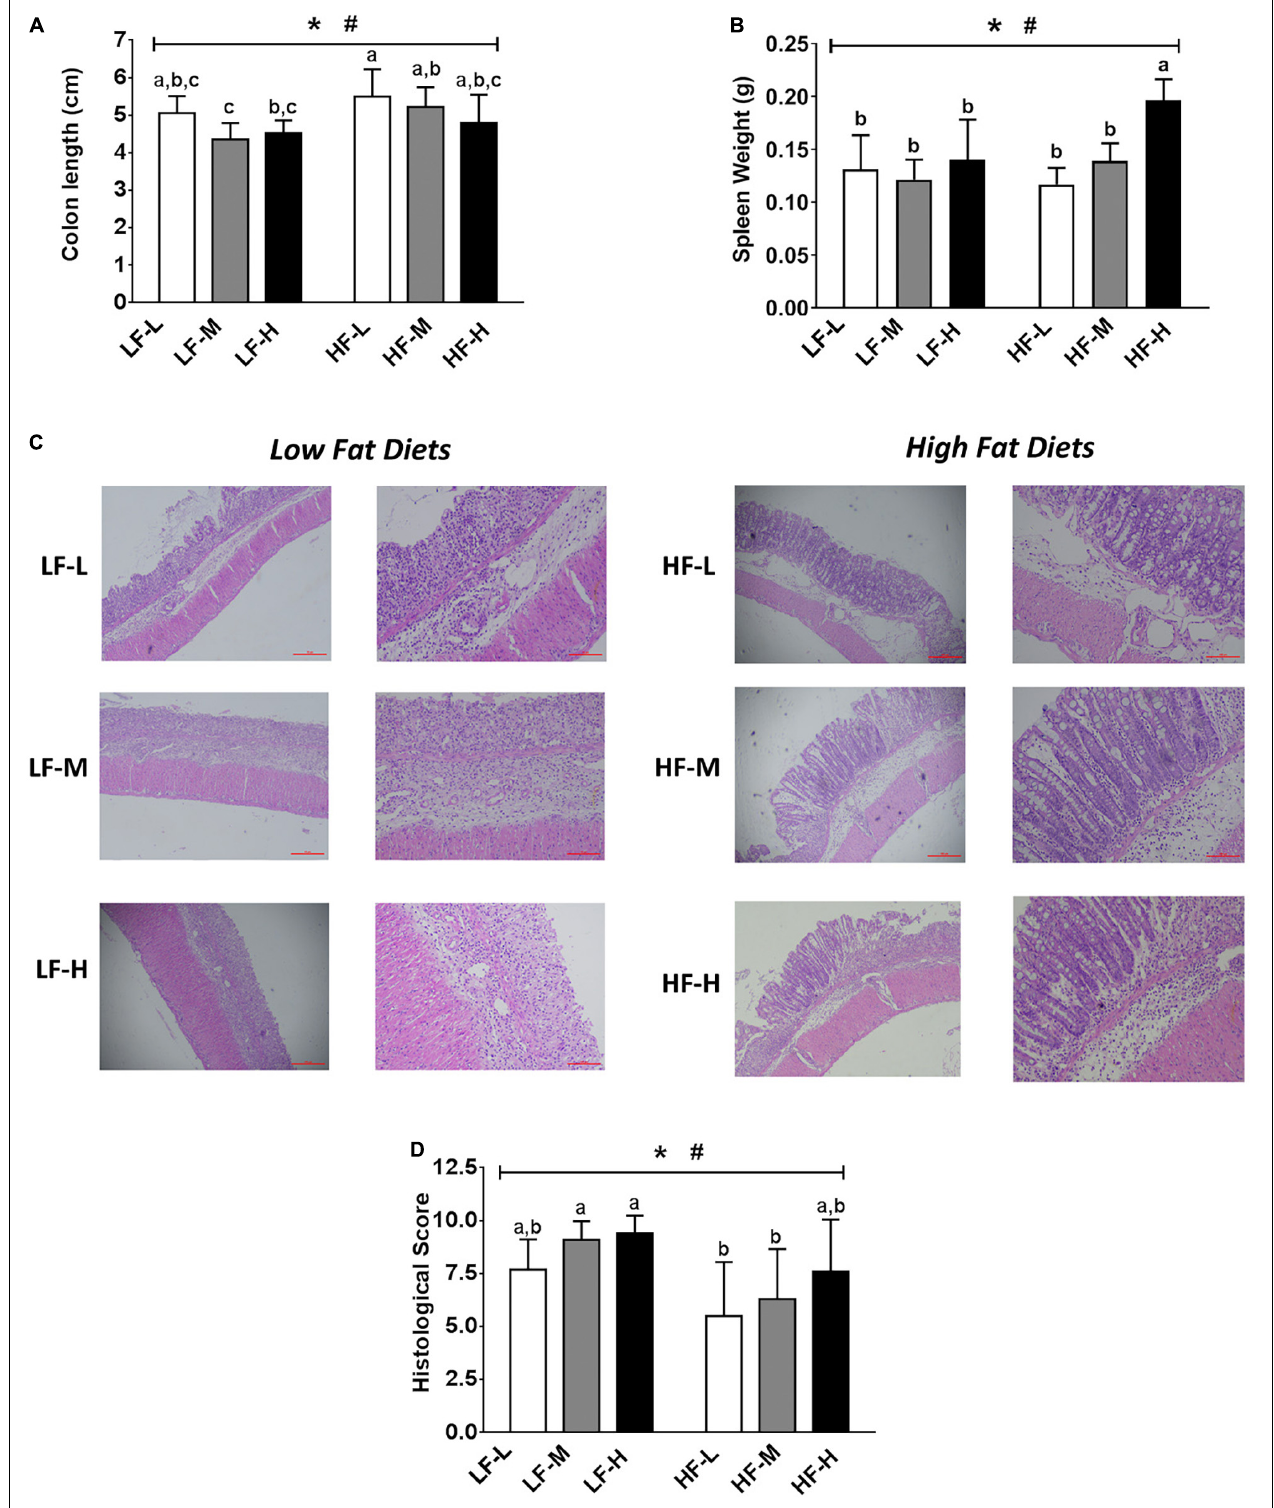
FIGURE 3 | (A) Colon lengths of the mice. (B) Spleen weights of mice. (C) Histopathological examination and (D) evaluation of histopathological severity scores of the colon tissue. Bars with the same letter indicate a non-significant difference (P > 0.05). Asterisk indicates a significant difference between the high fat diet groups and low fat diet groups; # indicates a significant difference between the mice from groups fed with the diets of different LA/ALA ratios.